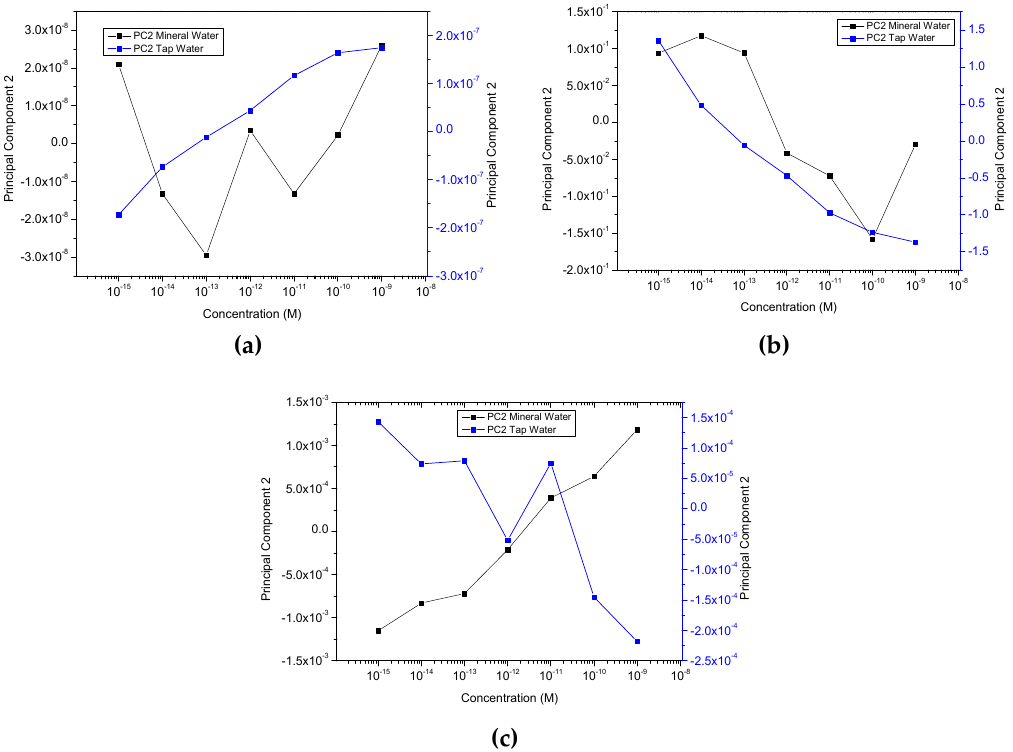
Figure 7. Plots of Principal Component 2 calculated values from capacitance ( a ), loss tangent ( b ) and ( c ) electric modulus spectra for mineral and tap waters as a function of logarithm of the sample’s concentrations. The lines between the plotted points are only guidelines.